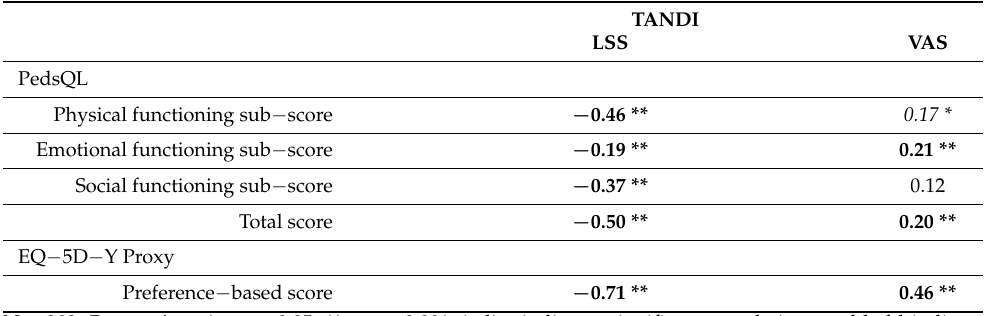
Table 4. Summary table of TANDI concurrent validity. (Total Sample N = 203).